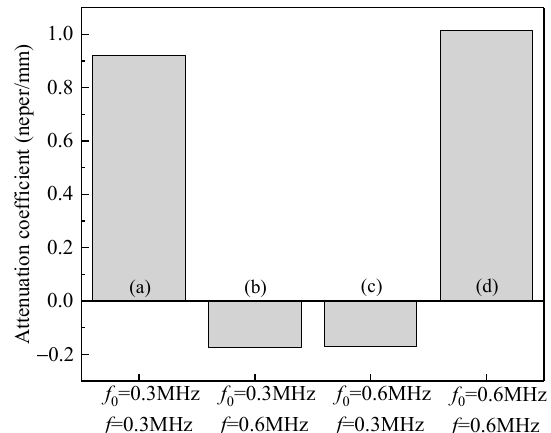
Figure 11. Kinetic energies (mJ): ( a ) f 0 = 0.3 MHz, f = 0.3 MHz; ( b ) f 0 = 0.3 MHz, f = 0.6 MHz; ( c ) f 0 = 0.6 MHz, f = 0.3 MHz; ( d ) f 0 = 0.6 MHz, f = 0.6 MHz.